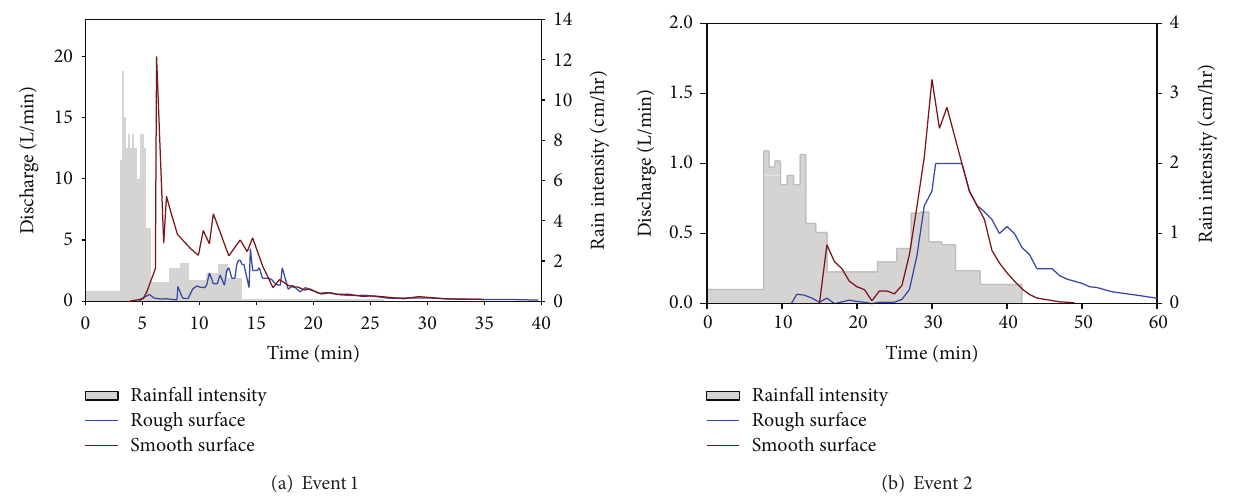
Figure 8: Comparisons of observed hydrographs for the rough and smooth field plots under two natural rainfall events (Event 1: short- duration heavy rainfall on June 26, 2011; Event 2: long-duration light rainfall on August 12, 2011).